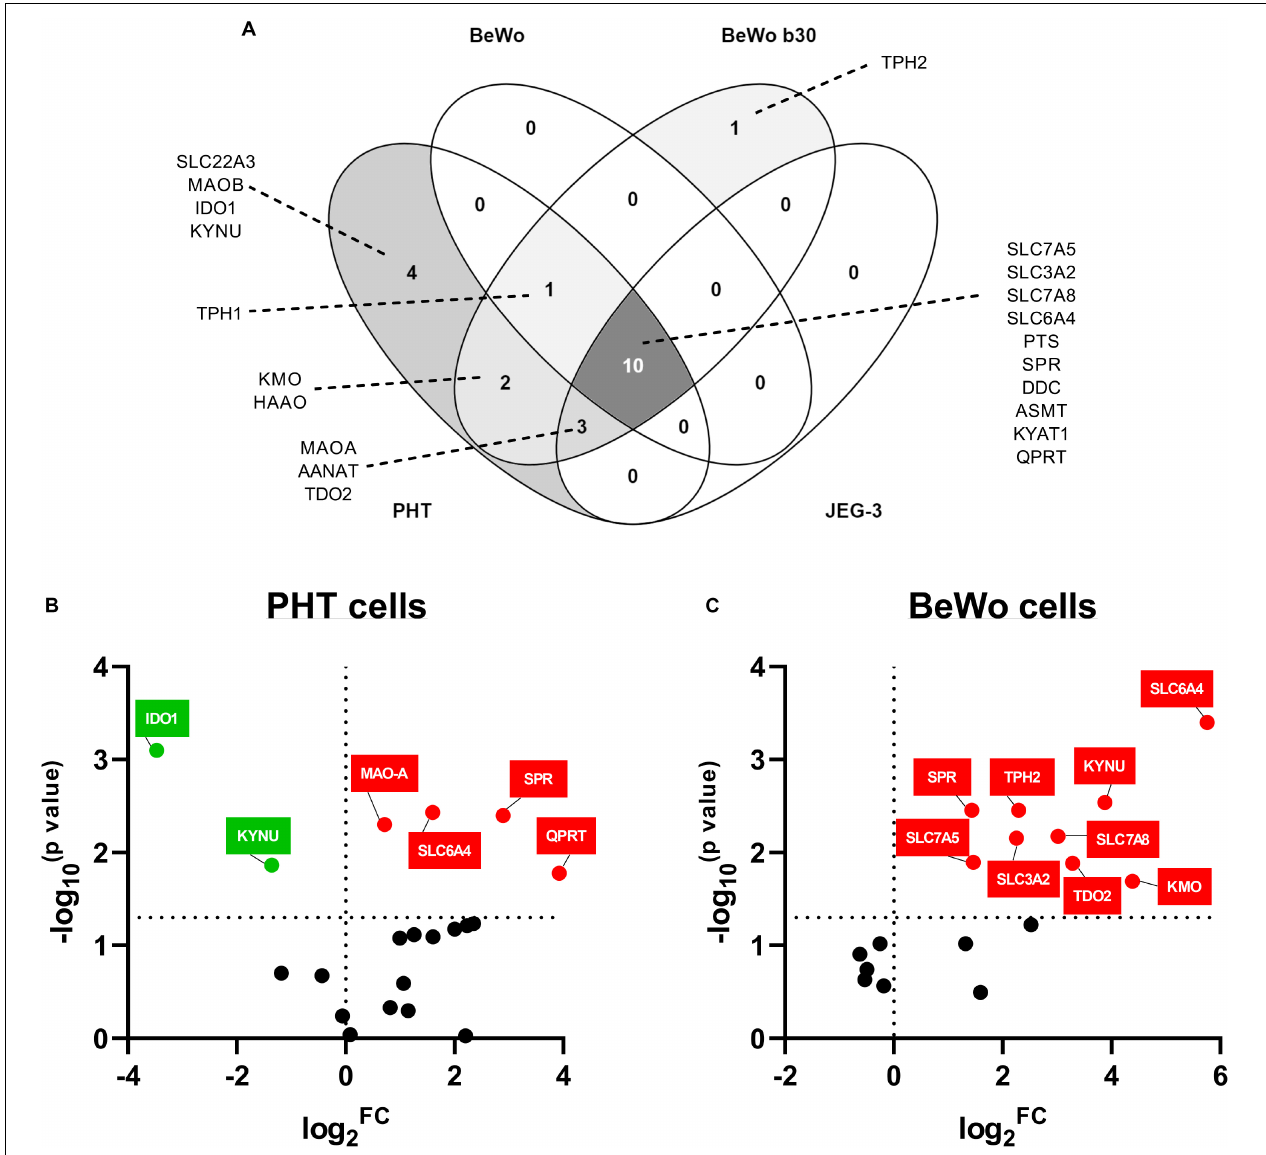
FIGURE 5 | Gene expression of TRP pathway-related enzymes and transporters in placental-derived cells. Placental-derived cells were obtained from three different passages of BeWo, BeWo b30, and JEG cells and five isolations of primary human trophoblast cells (PHT). (A) Venn diagram of the overlap in gene expression among four cell lines. PHT and BeWo b30 cells share the highest gene homology, with the PHT cells additionally expressing four important genes, including the rate-limiting enzyme, IDO1 , and the polyspecific organic transporter, SLC22A3 . Subsequently, effect of differentiation in these two cell lines was tested, revealing dissimilarity between spontaneous syncytialization (B) and forskolin-induced differentiation (C) . Data are visualized as volcano plots of fold changed expression in the differentiated cells, compared to the undifferentiated counterpart. Color indicates statistically significant changes: red – up-regulation, green – down-regulation. Statistical significance was evaluated using Mann–Whitney